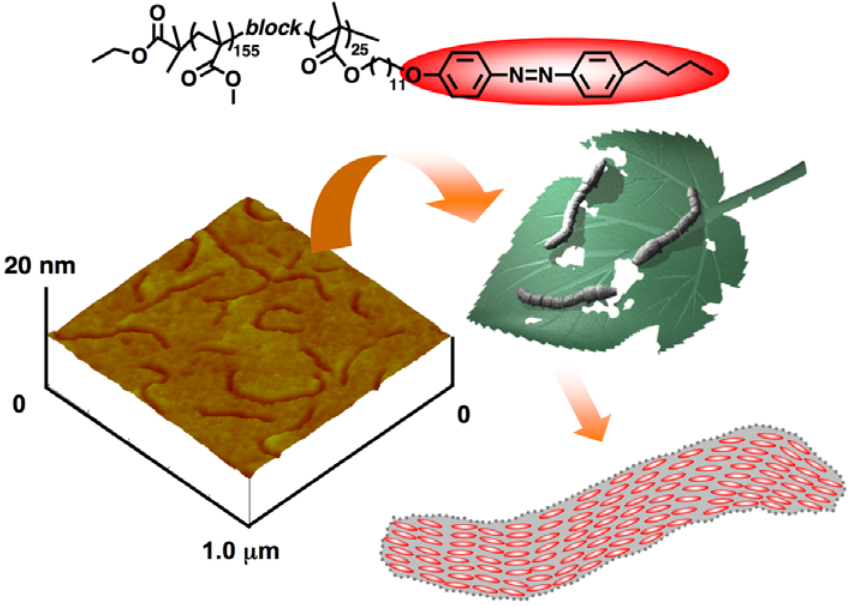
Figure 10. Wormlike nanostructures obtained in a PRBC showing an LC